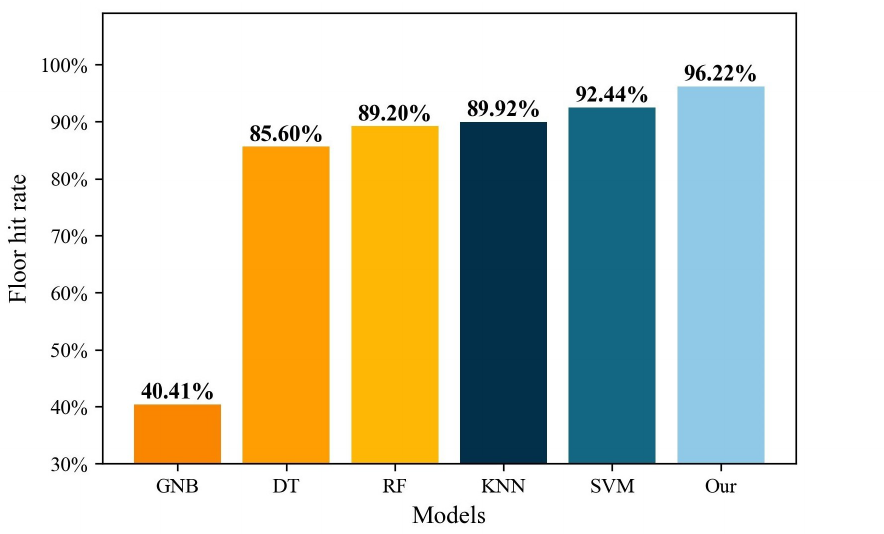
Figure 7. Comparison of our algorithm and machine learning methods for multi-floor positioning.